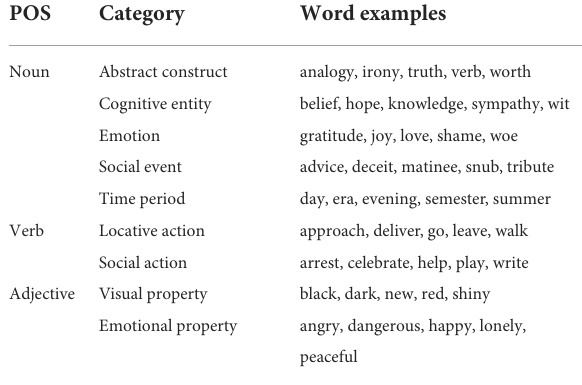
TABLE 3 Example of words included in Binder et al.’s (2016) dataset, which are selected mainly from abstract